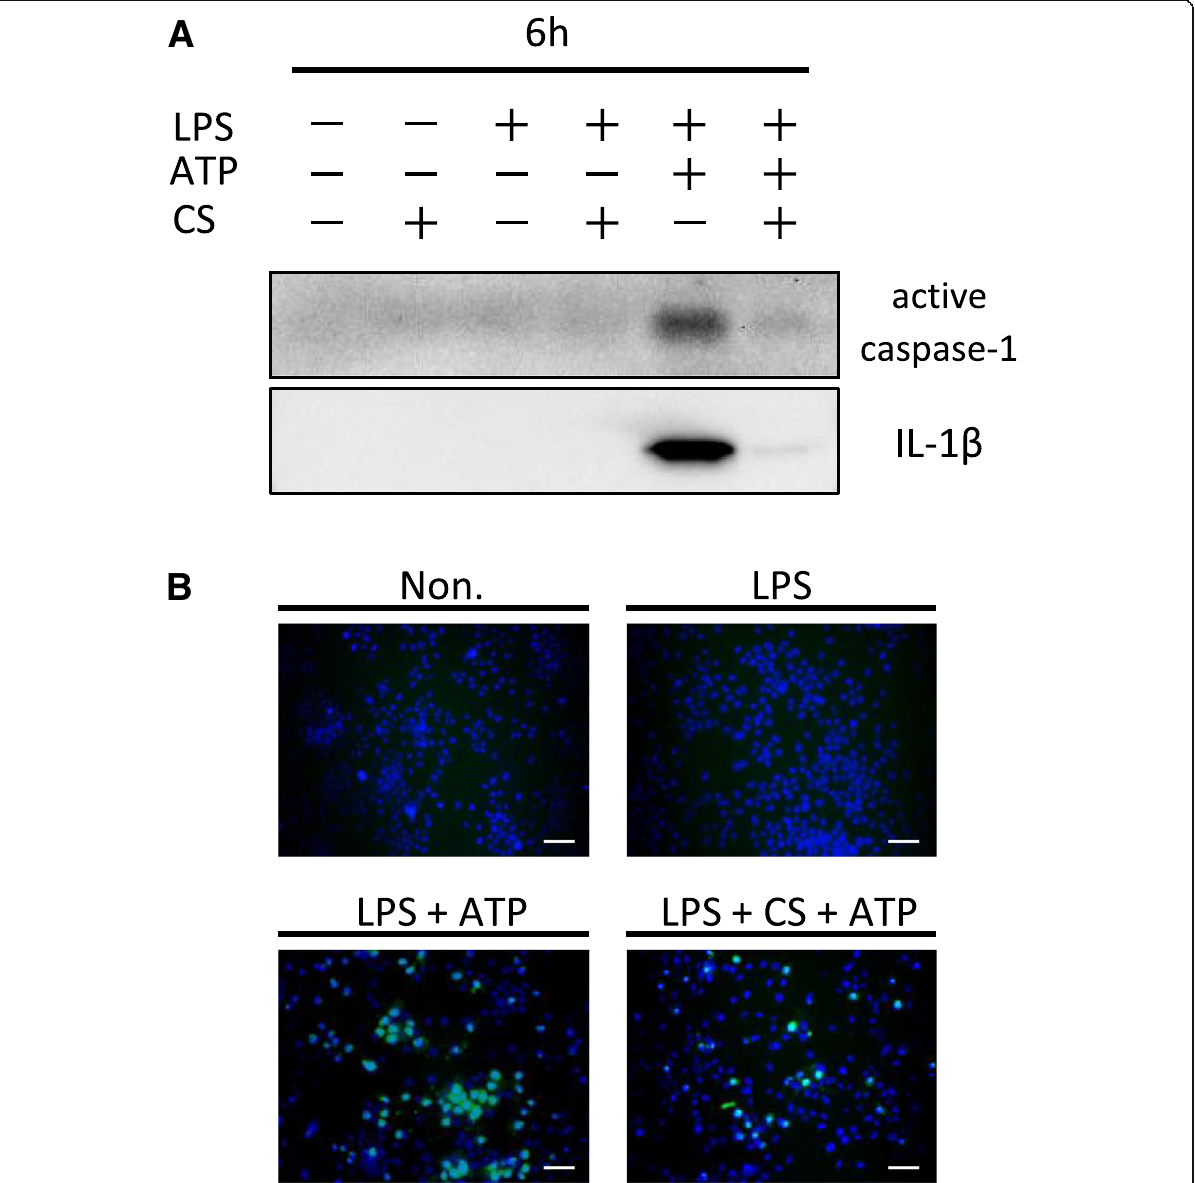
Fig. 5 Cyclic stretch inhibits LPS/ATP-induced activation of caspase-1. J774.1 cells were exposed to cyclic stretch of 20% elongation at a frequency of 10cycles/min for the first 2h during treatment with 100ng/mL LPS for 4h followed by stimulation with ATP for 2h in the continuous presence of LPS. a Concentrated supernatants were analyzed by western blotting with specific antibodies to caspase-1 and IL-1 β . b Cells were labeled with a FLICA probe conjugated with FAM (green) and nuclei were visualized by staining with Hoechst 33342 (blue) (magnification, ×200; scale bars are 50 μ m). The negative control (Non.) was not treated with LPS, ATP, or cyclic stretch. CS, cyclic